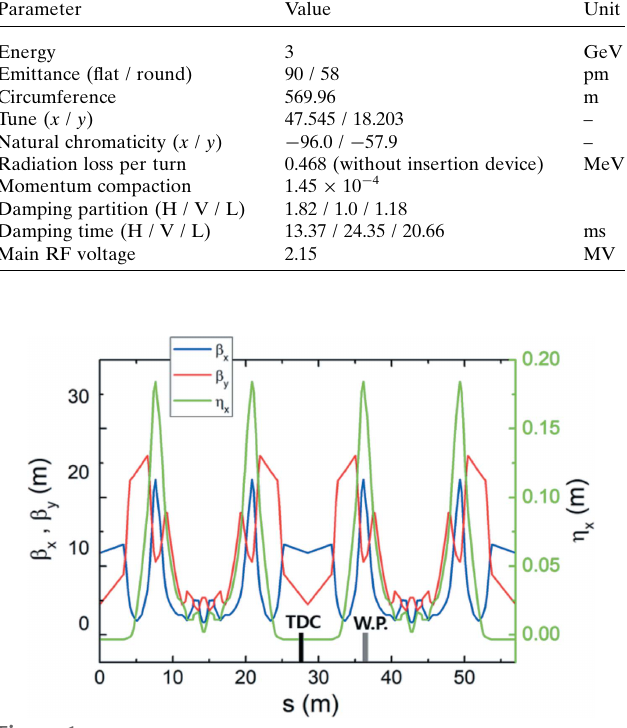
Figure 1 Twiss functions of PAL-4GSR (two cells) and the position of the transverse deflecting cavity and watching point.